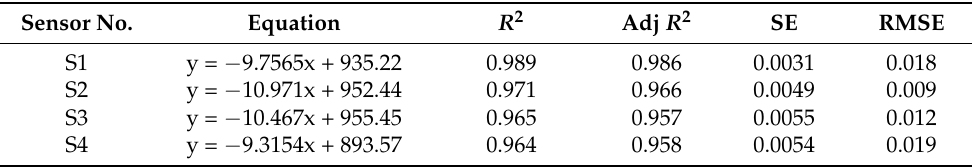
Figure 5. Calibration results of different soil moisture sensors tested. The results of the analysis are presented in Table 6. Table 6. Regression analysis results: equation, determination coefficient ( R 2 ), root-mean-square error (RMSE) between sensor readings (millivolt) and gravimetric moisture content.